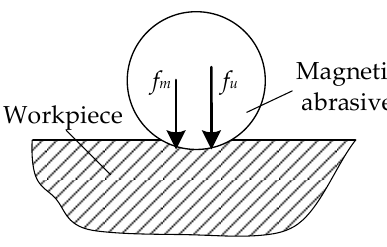
Figure 2. Analysis of cutting force.